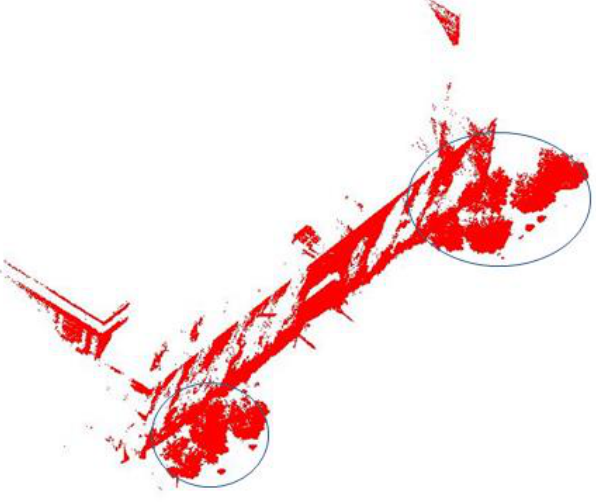
Figure 13. Accuracy errors by trees near buildings.